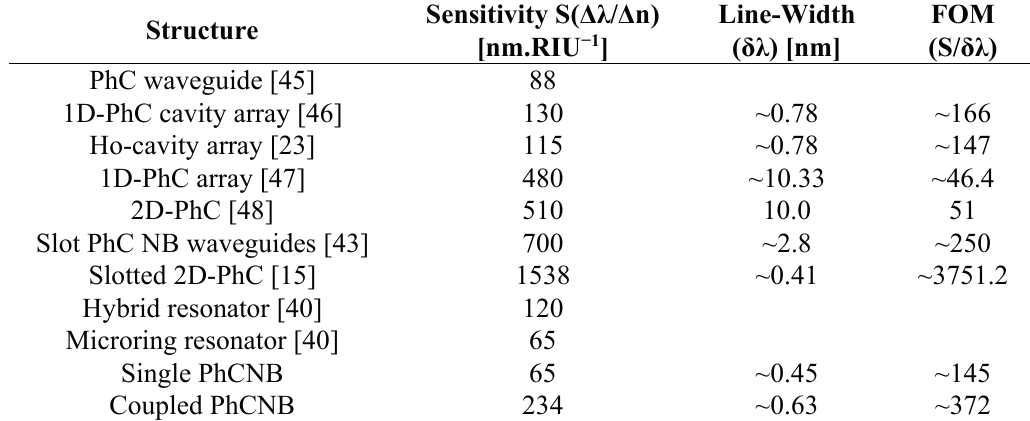
Table 2. Sensitivity, line-width and figure of merit (FOM) of various optical structures compared to our experimental